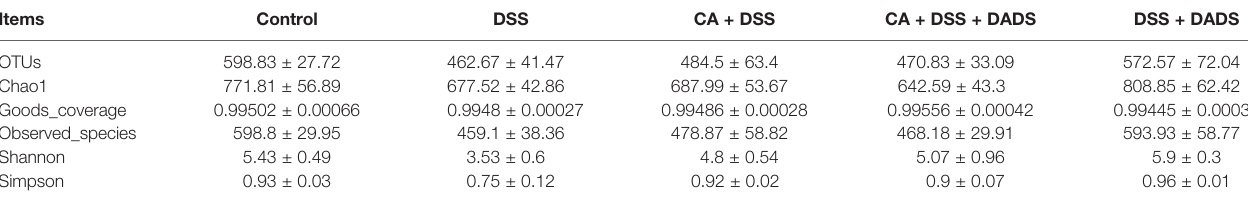
TABLE 1 | The alpha diversity in each group of mice.